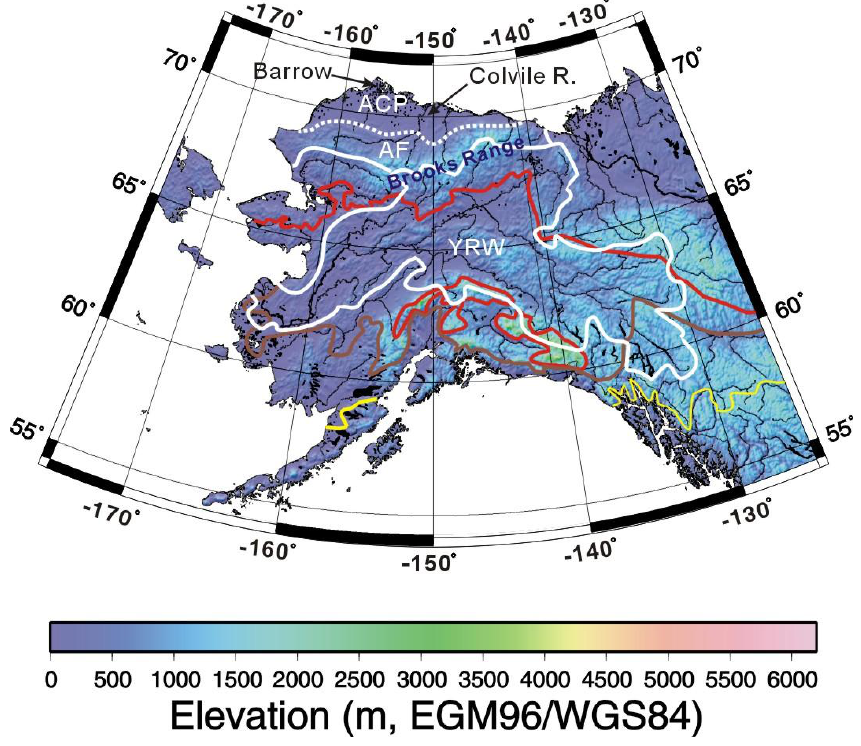
Figure 1. ESA Altimetry Corrected Elevation version-2 Global Digital Elevation Model shaded relief showing Alaska, USA, and western Canada. The Yukon River watershed (YRW) extent, Arctic Foothills (AF) and Arctic Coastal Plain (ACP) are delineated (white). Permafrost zone extents of the Isolated-Sporadic (yellow), Discontinuous (brown), and Continuous (red) are based on Jorgenson et al. (2008).